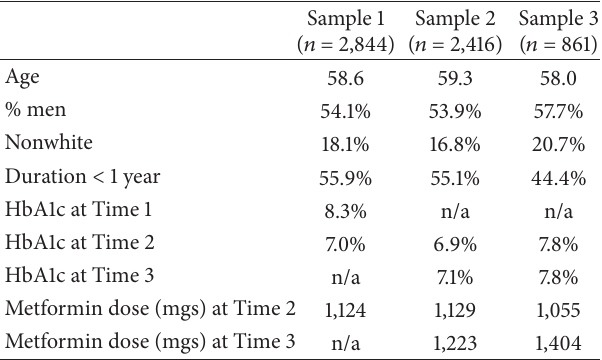
Table 1: Characteristics of three analysis samples. Sample